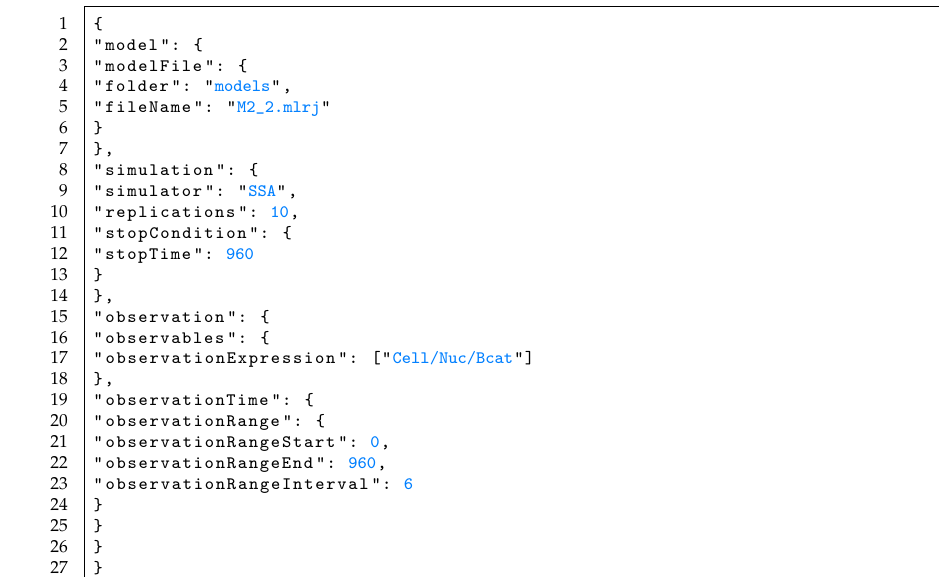
Listing 3. Cross-validation experiment in the exchangeable JSON format, with the inputs (blue) already adapted for the Haack et al.